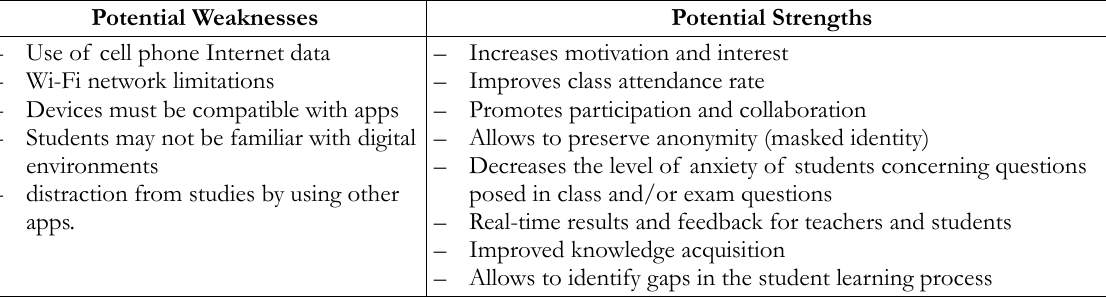
Table 1. Strengths and weaknesses of the M-Learning